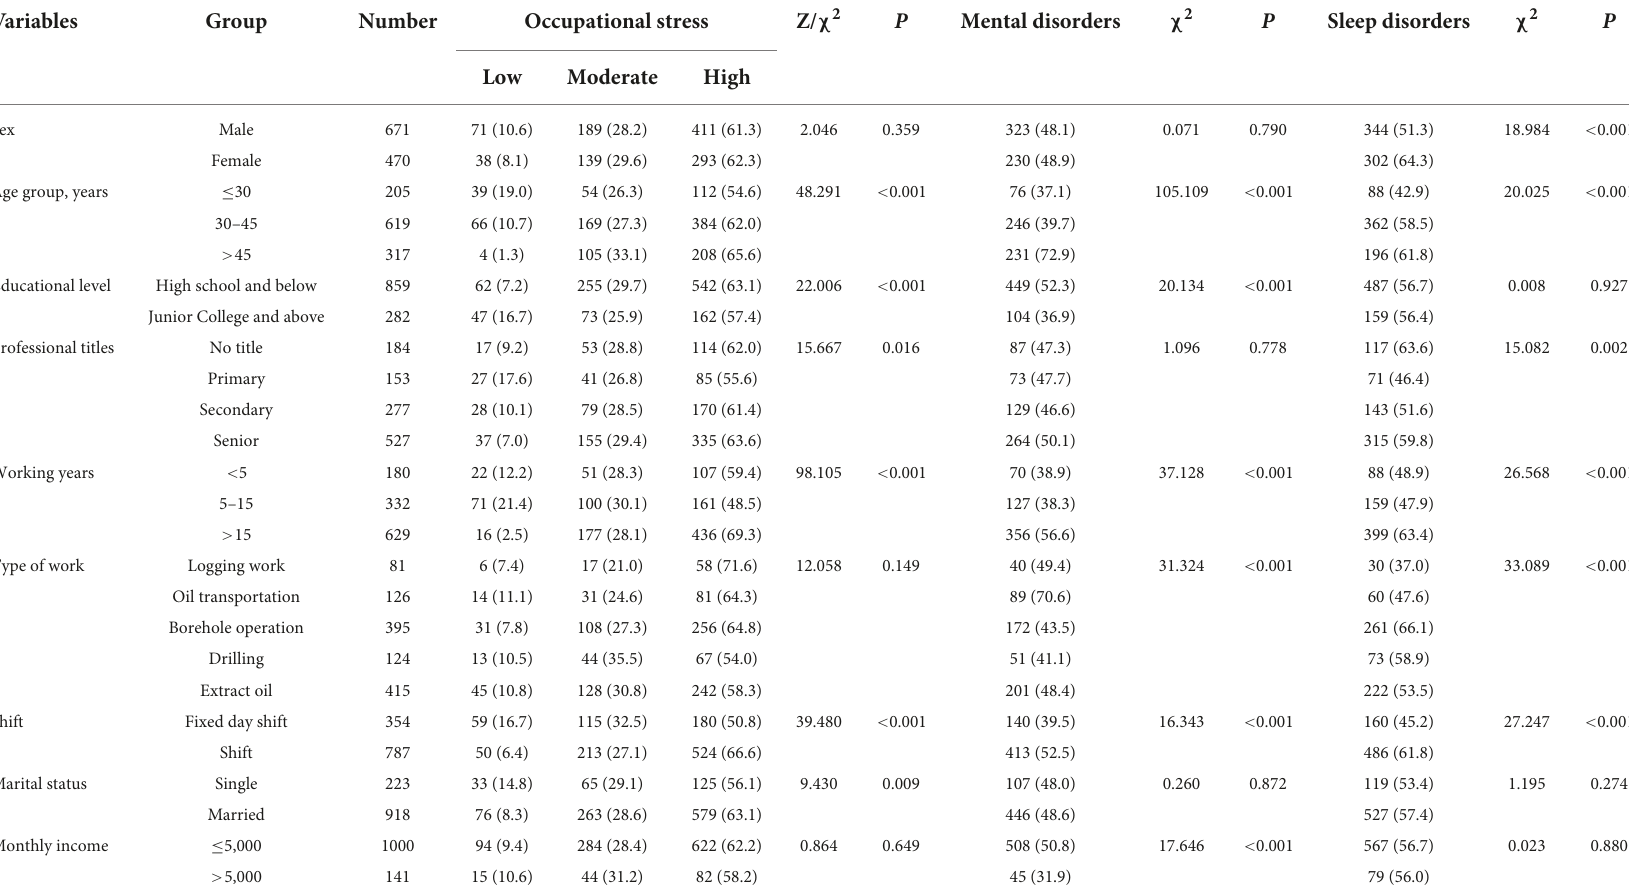
TABLE 2 Comparison of the incidence of occupational stress, psychological disorders and sleep disorders among oil workers with different demographic